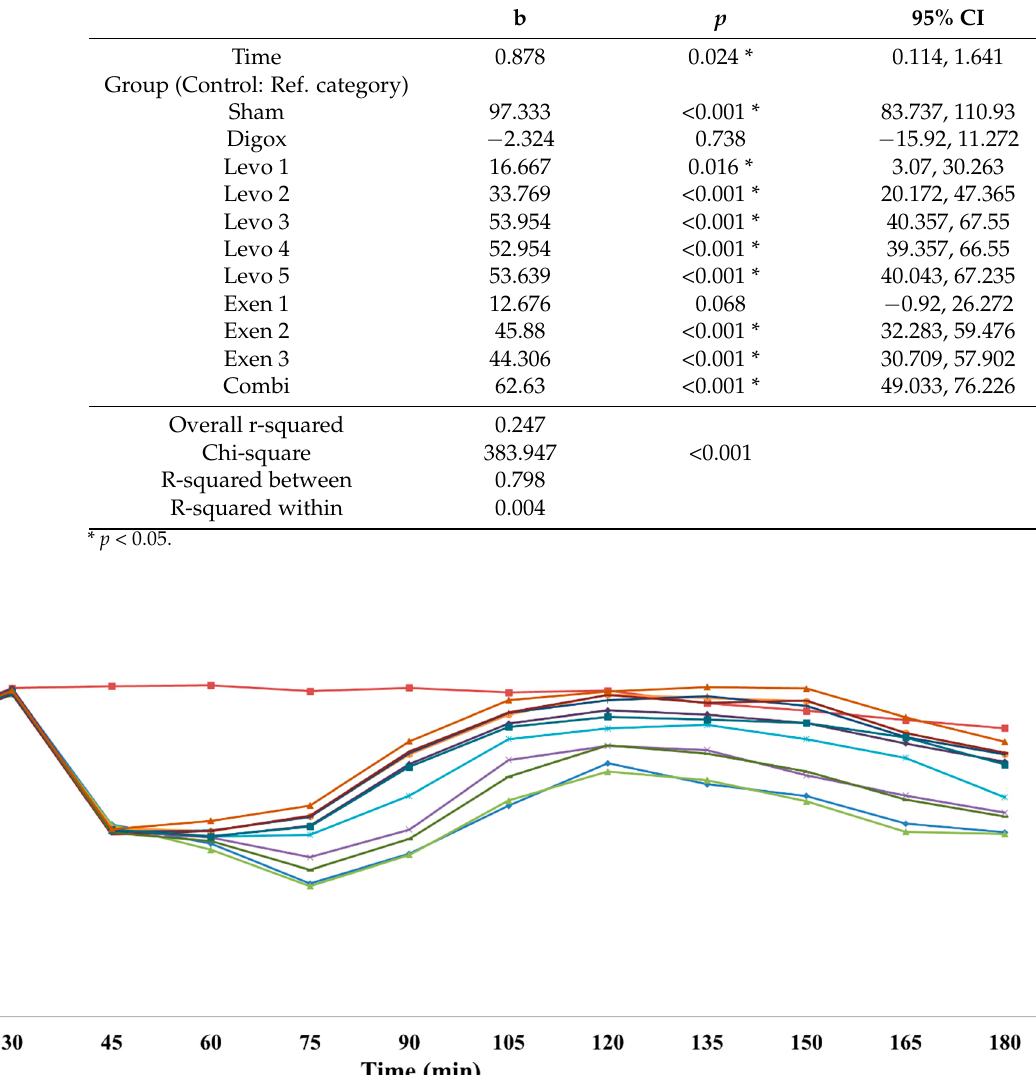
Table 4. Longitudinal analysis for HR for all groups.